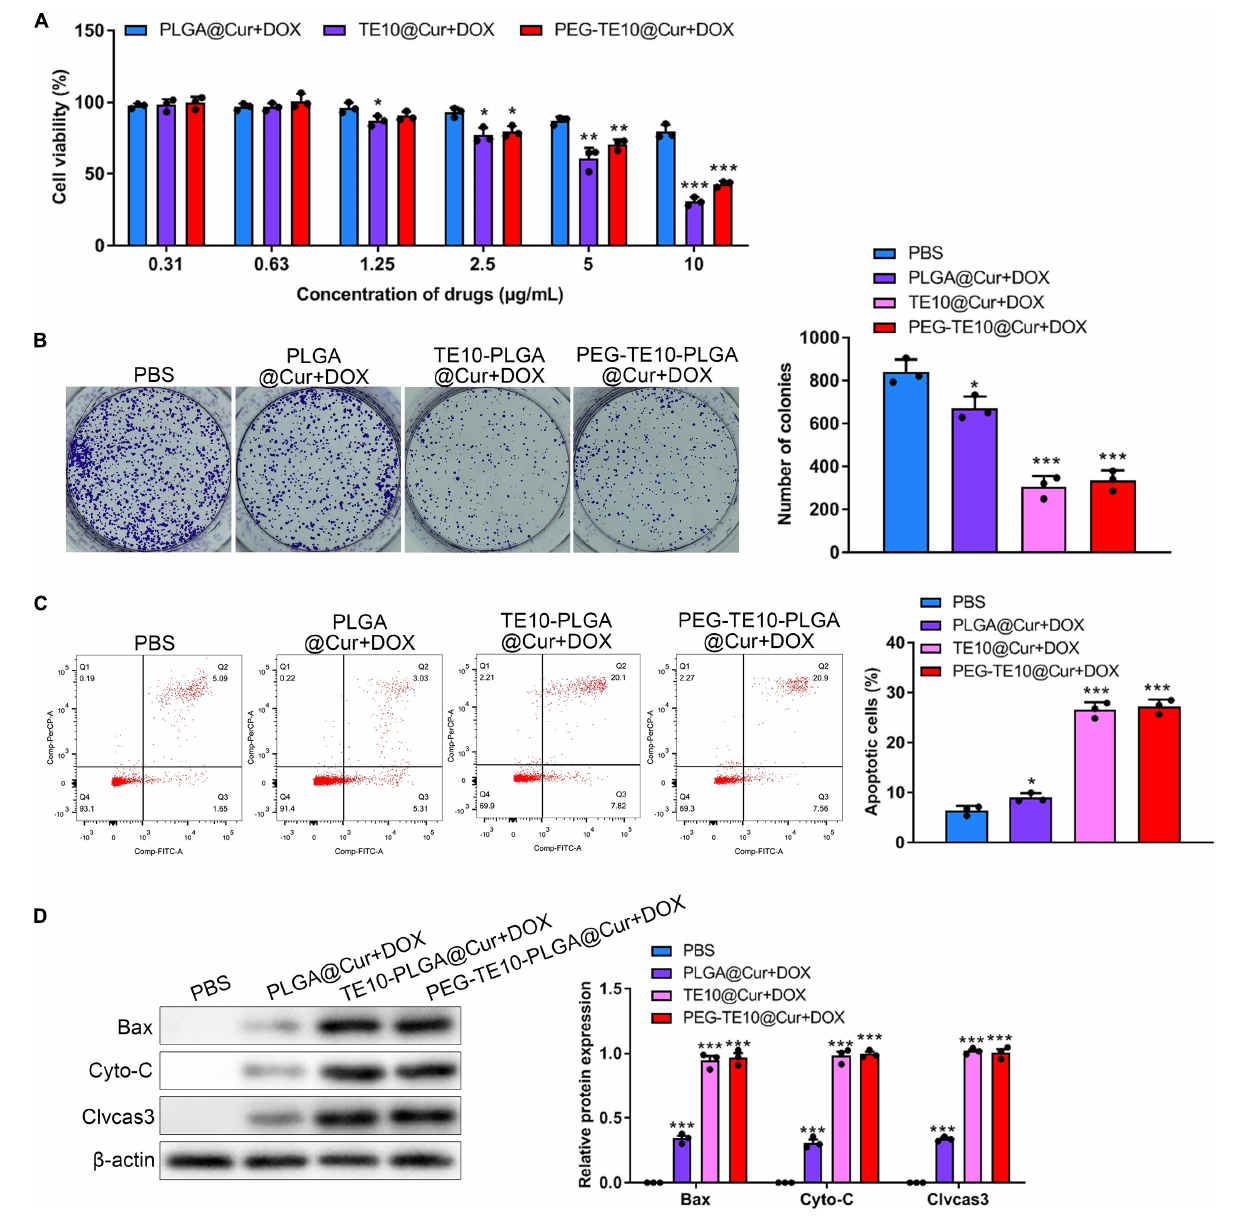
FIGURE 3 | In vitro anti-tumor activity of PMPNs. (A,B) Effect of PLGA@Cur + DOX, TE10-PLGA@Cur + DOX, and PEG-TE10-PLGA@Cur + DOX on proliferation of TE10/DOX cells was assessed through (A) CCK-8. (B) Clone formation assay (C) flow cytometry analysis of TE10/DOX cell apoptosis induced